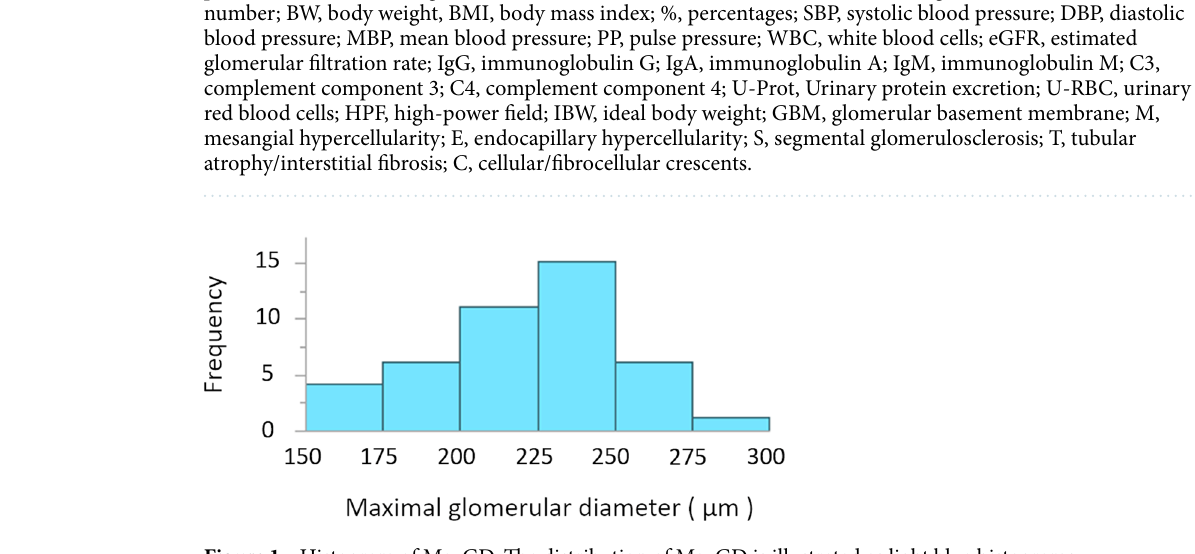
Figure 1. Histogram of MaxGD. The distribution of MaxGD is illustrated as light blue histograms. Abbreviation: MaxGD, maximal glomerular